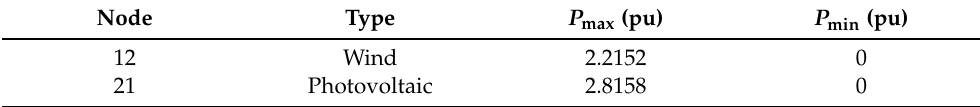
Table 4. Nominal sizes of the renewable energy sources.